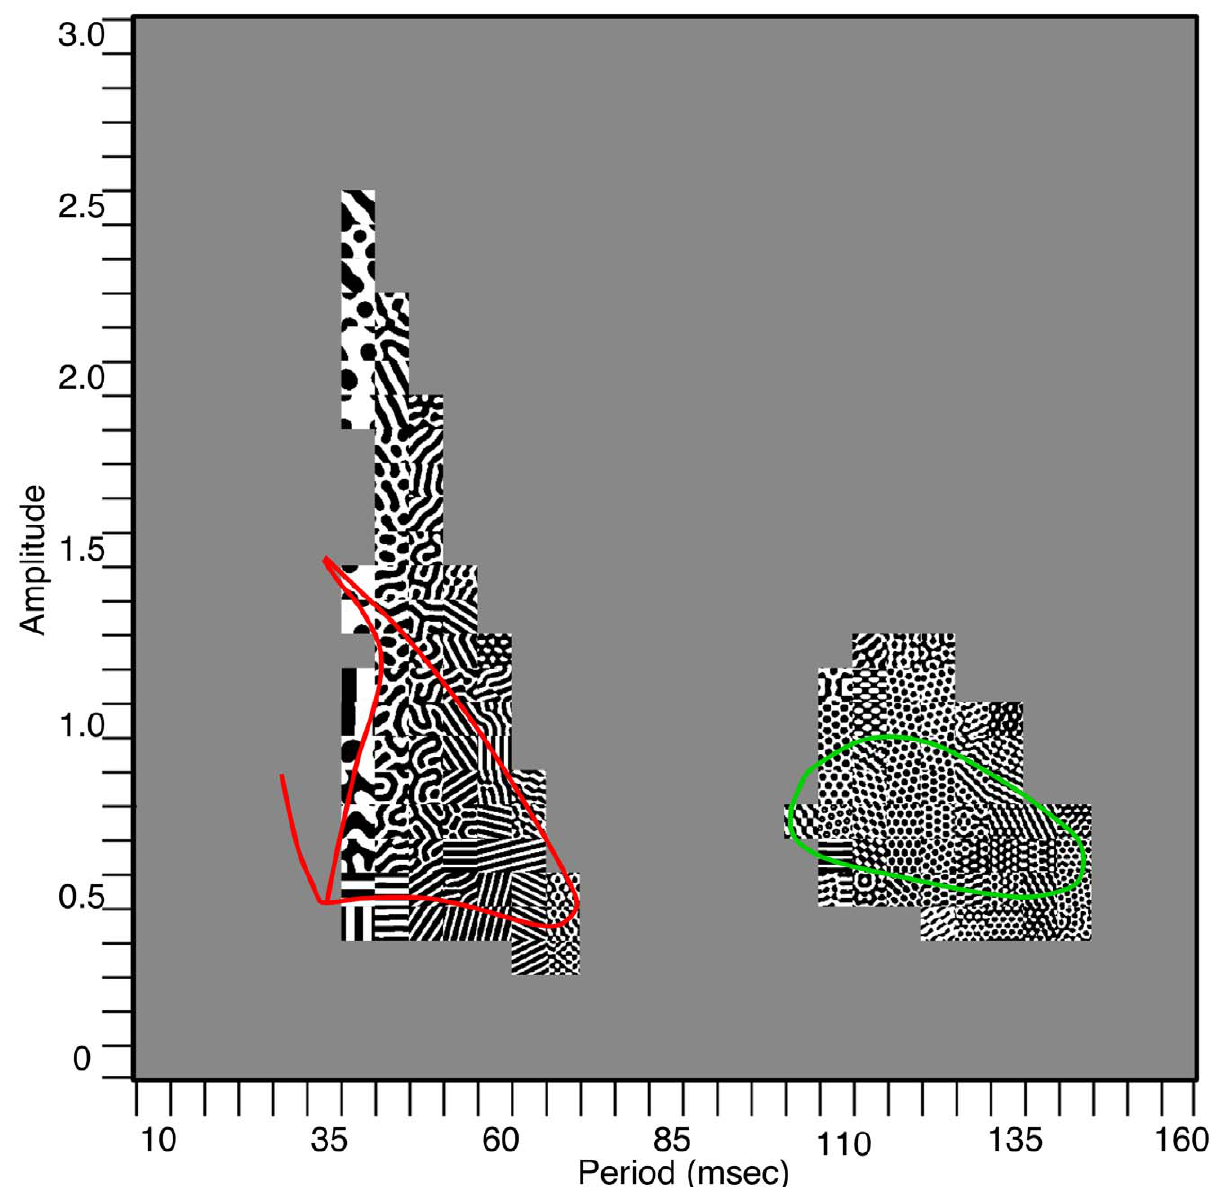
Figure 6. Two-parameter phase diagram for the model. Each square is a simulation of a 64 | 64 domain with periodic boundary conditions. Patterns are shown as the period and amplitude range over the relevant intervals. Colored curves represent the theoretical boundaries for instability of the spatially uniform state.